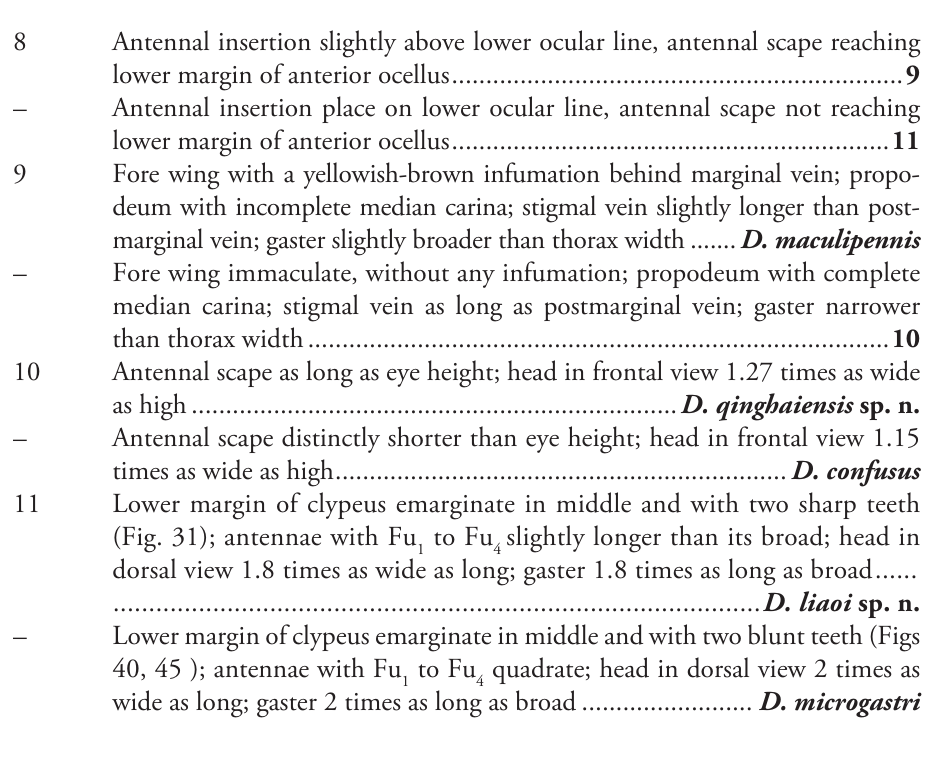
Diagnosis. Body dark green. Head in frontal view round; antennal insertion placed on lower ocular line and face not protuberant at antennal insertion; antennal formula 11263 (rarely 11353); lower margin of clypeus with two sinuate teeth; both mandibles with four teeth or right mandible with four teeth and left mandible with three teeth; head in dorsal view with occiput margined by blunt or sharp, transverse ridge. Meso- soma slightly convex; pronotal collar not margined or slightly carinate medially; notau- li incomplete and inconspicuous; scutellum without frenal groove; propodeum with plica complete, median carina developed or not. Fore wing without marginal fringe or at least bare between postmarginal vein and wing apex; postmarginal vein short, only inconspicuously longer than stigmal vein. Hind tibia with one spur. Gaster